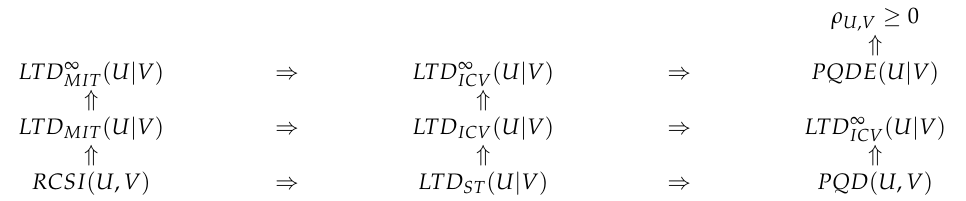
Table 8. Relationships among reversed weak dependence